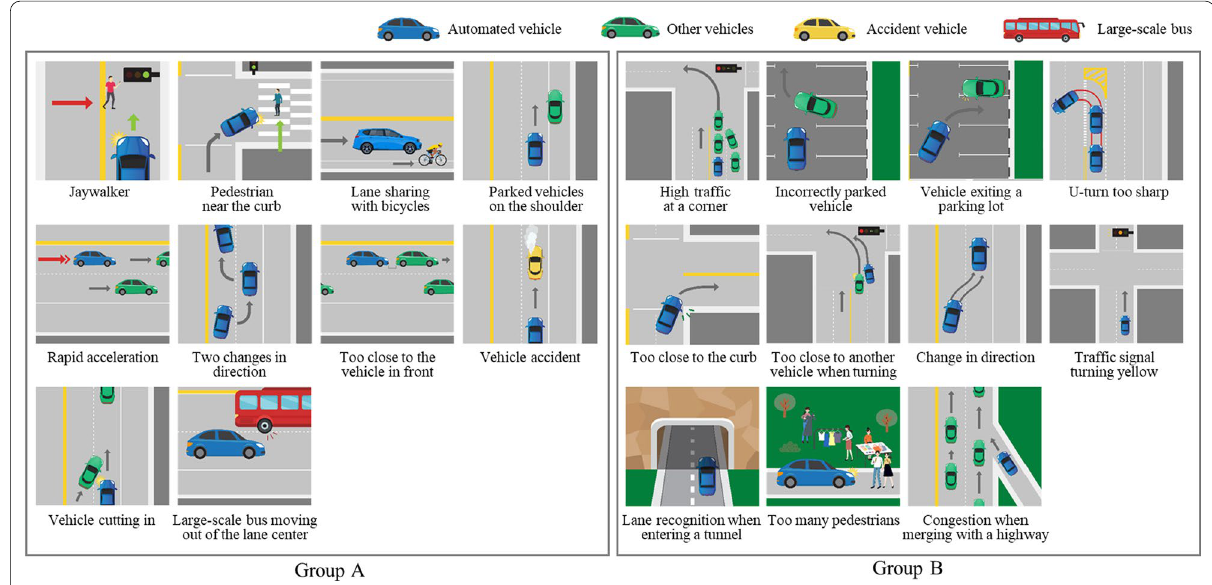
Fig. 1 The identified scenarios based on the distrust events